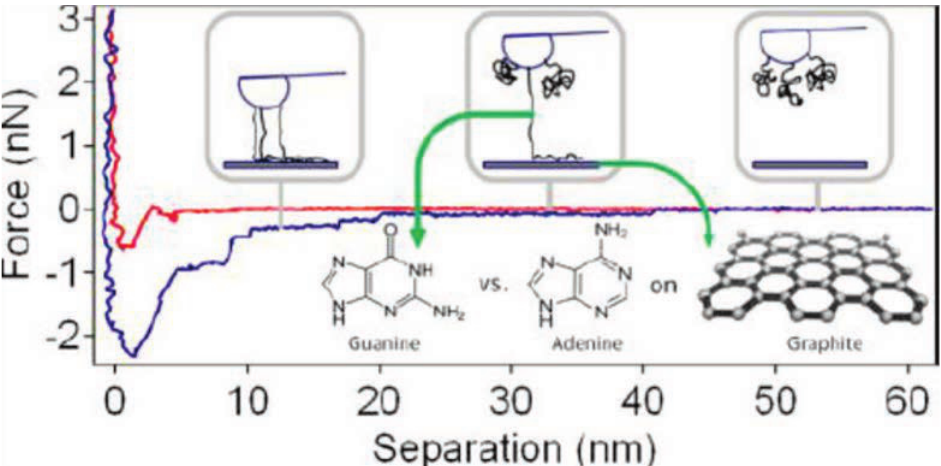
Figure 7. Cartoon (not drawn to scale) of frictionless peeling of an ssDNA homopolymer attached to a gold-coated force probe, from a graphite surface, with a typical force-distance curve for peeling ssDNA from the surface of graphite obtained at a tip velocity of 200 nm/s. Red curve is approach, blue is retraction. Reprinted with permission from [26]. Copyright 2013 American Chemical Society